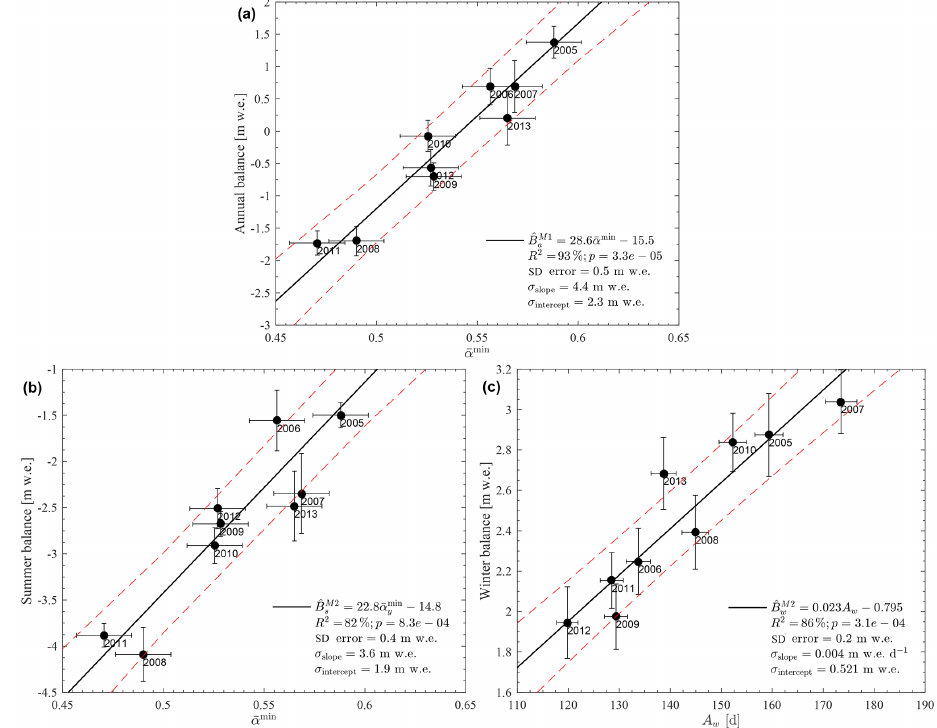
Figure 10. Unified linear regression between MODIS-derived minimum albedo and (a) annual balance, (b) summer balance, along with (c) the relationship between cumulative winter albedo and winter balance. Note the quality of the linear regression models conveyed by the coefficient of determination R 2 and the standard error of prediction. The dashed line is the standard error prediction interval.